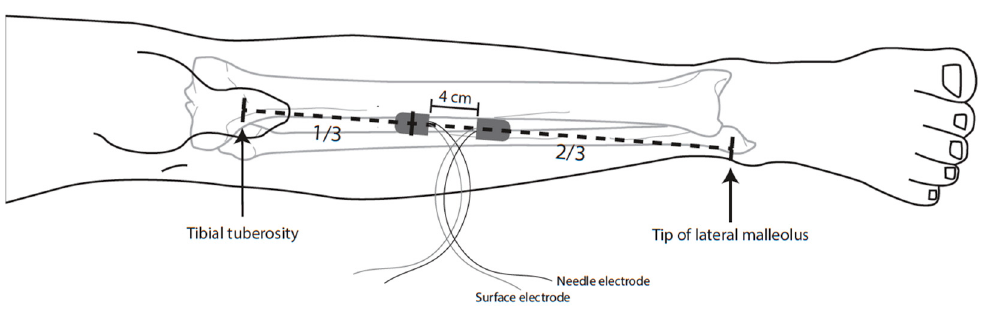
Figure 1. Placement of surface and subcutaneous needle recording electrodes on the tibialis anterior muscle of the right